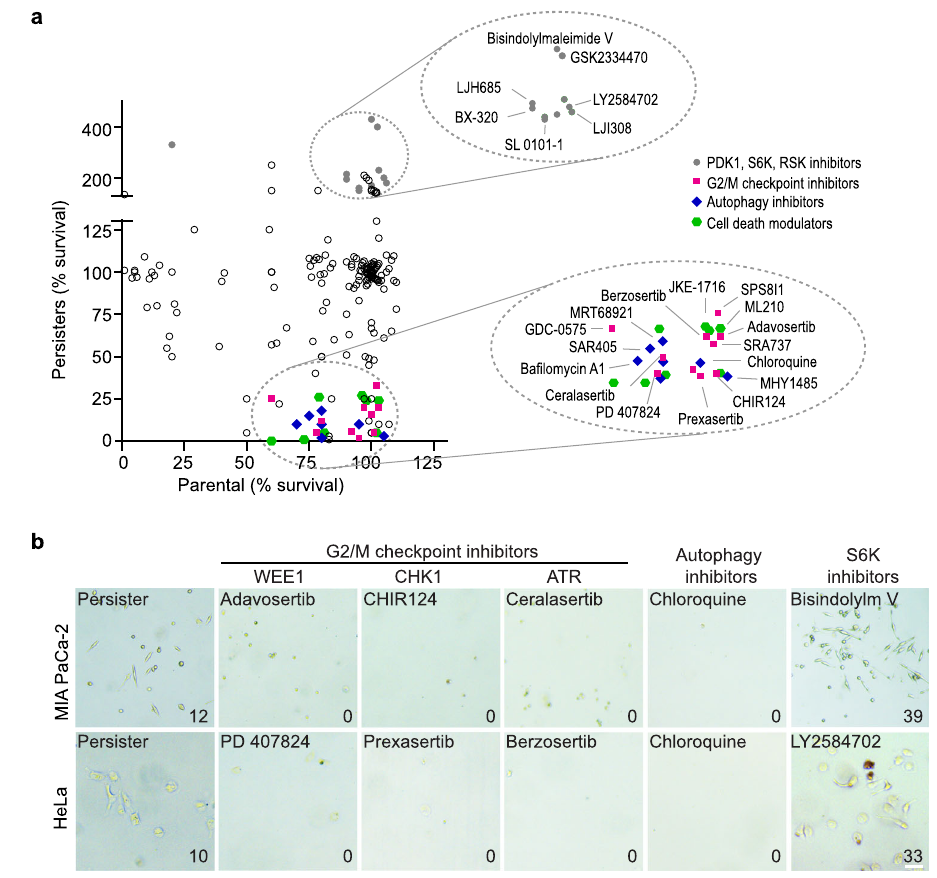
Fig. 5 | Multifaceted survival mechanisms in persisters revealed by a small- molecule chemical screen. a Effects of inhibitors on survival of MIA PaCa-2 pers- ister and parental cells. Each chemical was plotted based on its effects on parental and persister survival. For each drug, survival data were normalized to untreated parental and persister cells. Dashed circles indicate four major groups of drugs modulating persister survival. b Representative images of persister survival fol- lowingtreatmentwithinhibitorsinthechemicallibrary.MIAPaCa-2persisterswere induced by the combined treatment with 100nM gemcitabine and 100nM Torin1